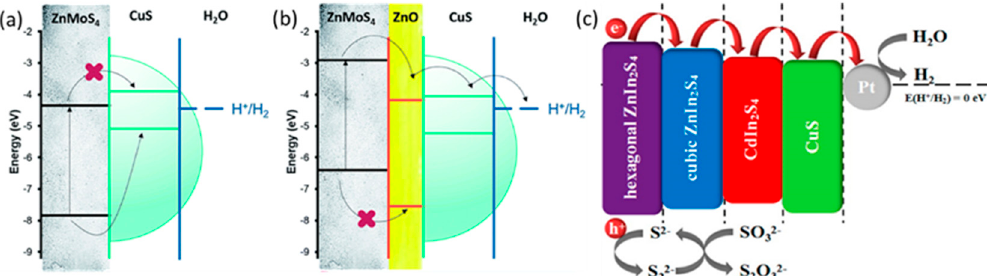
Figure 8. Electronic band alignments relative to water redox potentials and possible transfer routes of electrons and holes in ( a ) ZnMoS 4 / CuS and ( b ) ZnMoS 4 / ZnO / CuS. Adapted with permission from [35]; ( c ) energy band structure and corresponding photocatalytic reaction mechanism for H 2 production over the CuS / CdIn 2 S 4 / ZnIn 2 S 4 composite in Na 2 S − Na 2 SO 3 aqueous solution. Adapted with permission from [36].